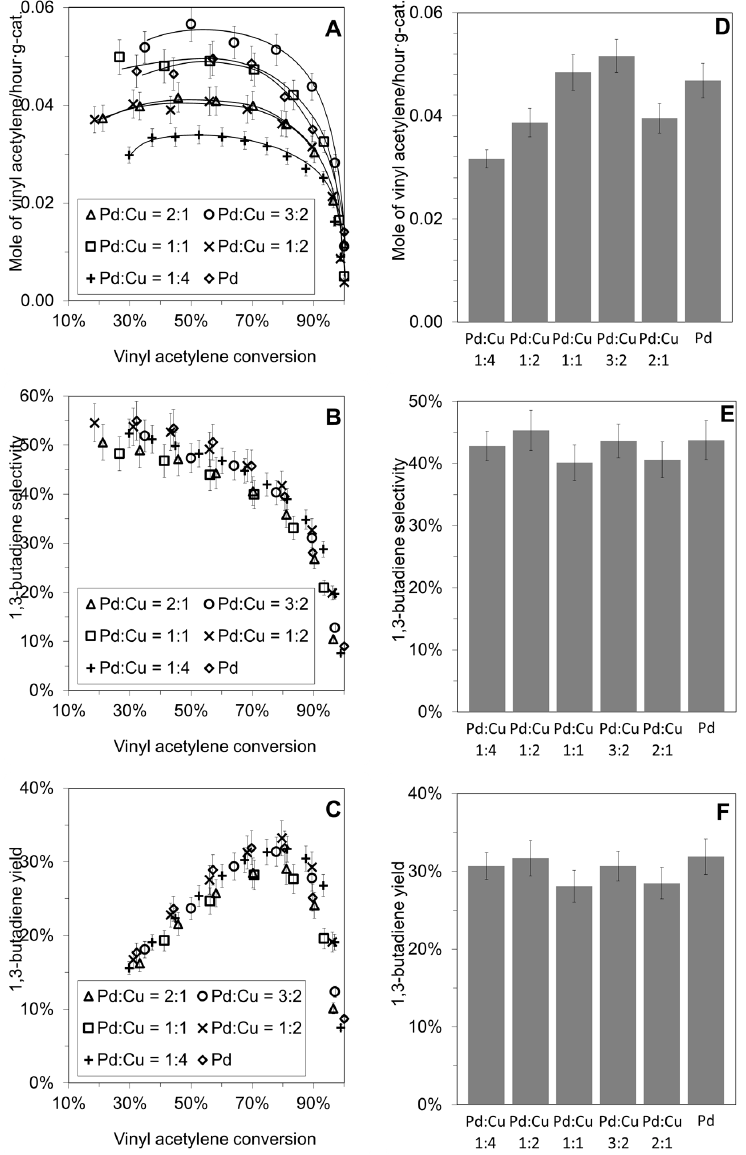
Figure 1. Catalytic performances: ( A ) reaction rate; ( B ) 1,3 ‐ butadiene selectivity; and ( C ) 1,3 ‐ butadiene yield as the function of vinyl acetylene conversion; ( D ) rate of vinyl acetylene at 70% vinyl acetylene conversion; ( E ) 1,3 ‐ butadiene selectivity at 70% vinyl acetylene conversion; and ( F ) 1,3 ‐ butadiene yield at 70% vinyl acetylene conversion against Pd:Cu atomic ratios.